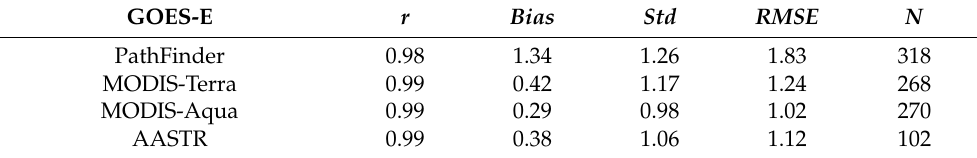
Figure 2. Instantaneous LST as derived from the JPL archive for PathFinder and from GOES-E UMD. Red dot : PathFinder data; Blue dot: GOES-E UMD. Period covered is 2004–2008.